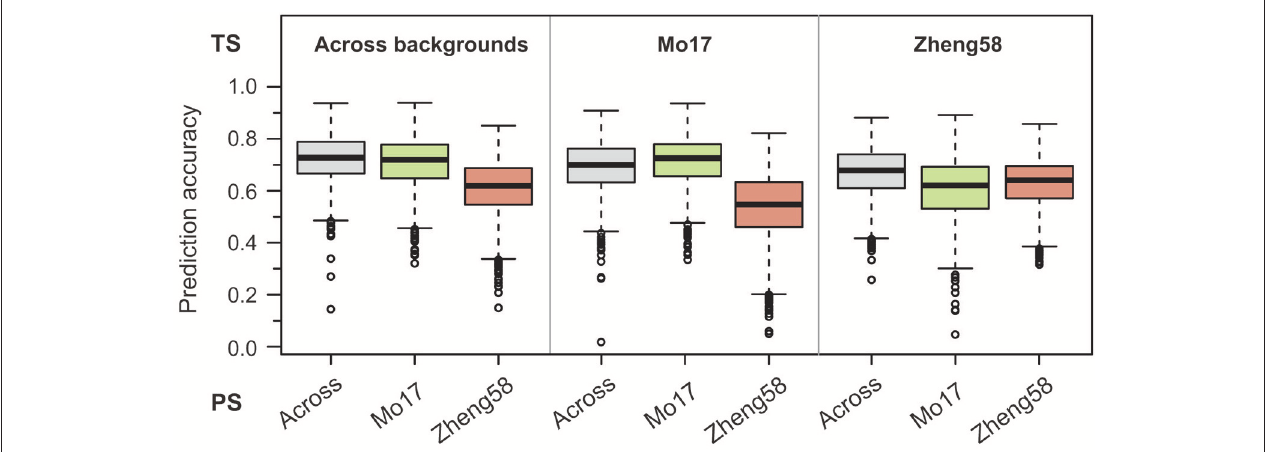
FIGURE 5 | Genome-wide prediction for haploid male fertility. Prediction accuracy from fivefold cross-validation is shown for effect estimation in the training set (TS) comprising either the BLUEs across both genetic backgrounds, the “Mo17” or the “Zheng58” background, and subsequent prediction in the three sets of BLUEs as prediction set